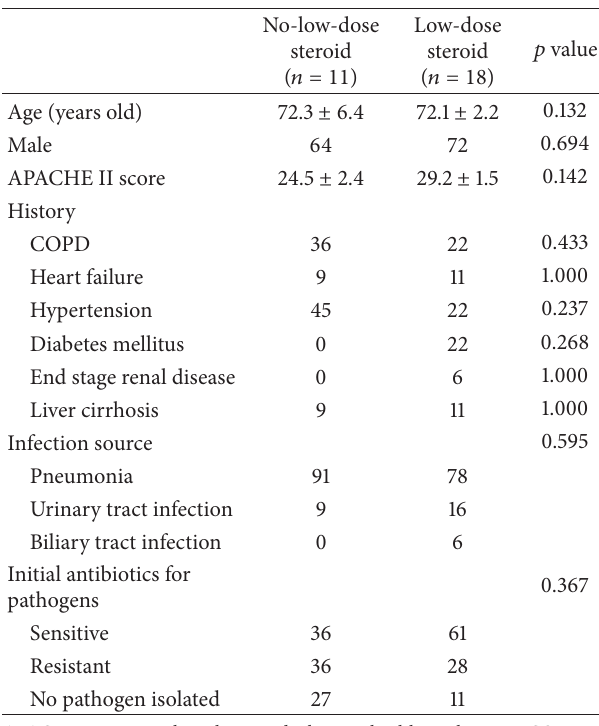
Table 1: Clinical characteristics of severe septic patients with and without low-dose steroid use (percentage, mean ± standard error mean).